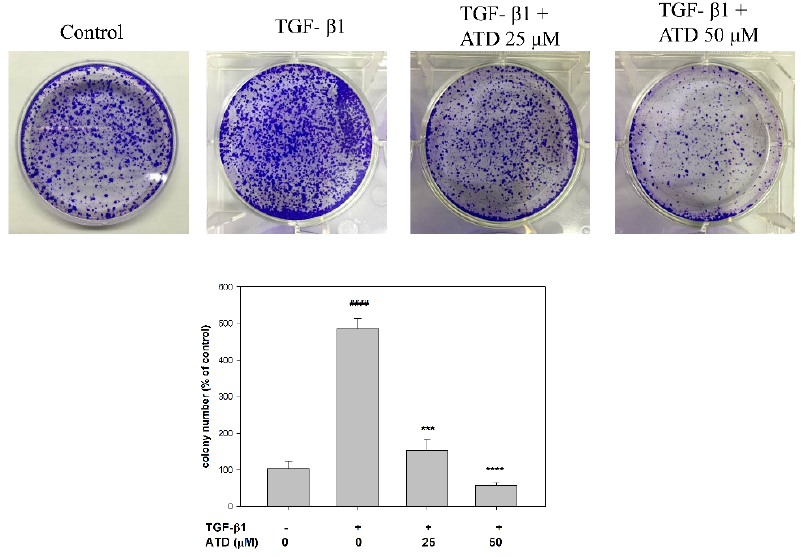
Figure 5. Effect of ATD on TGF- β 1-promted growth in HepG2 hepatoblastoma cells by colony formation assay. After treatment with ATD or cotreatment ATD and TGF- β 1 for 24 h, 1000 cells were seeded on 6-well plate and cultured for 2 weeks, then cells were fixed with methanol and stained with crystal violet. Colony numbers were quantified by ImageJ software. Data are represented as the mean ± SD from the three independent experiments. # p < 0.05, ## p < 0.01, #### p < 0.0001, compared with the control group treated (0.2% DMSO). ***: TGF- β 1 vs . TGF- β 1+ 25 μ M ATD, p < 0.001; ****: TGF- β 1 vs . TGF- β 1+ 50 μ M ATD, p < 0.0001.